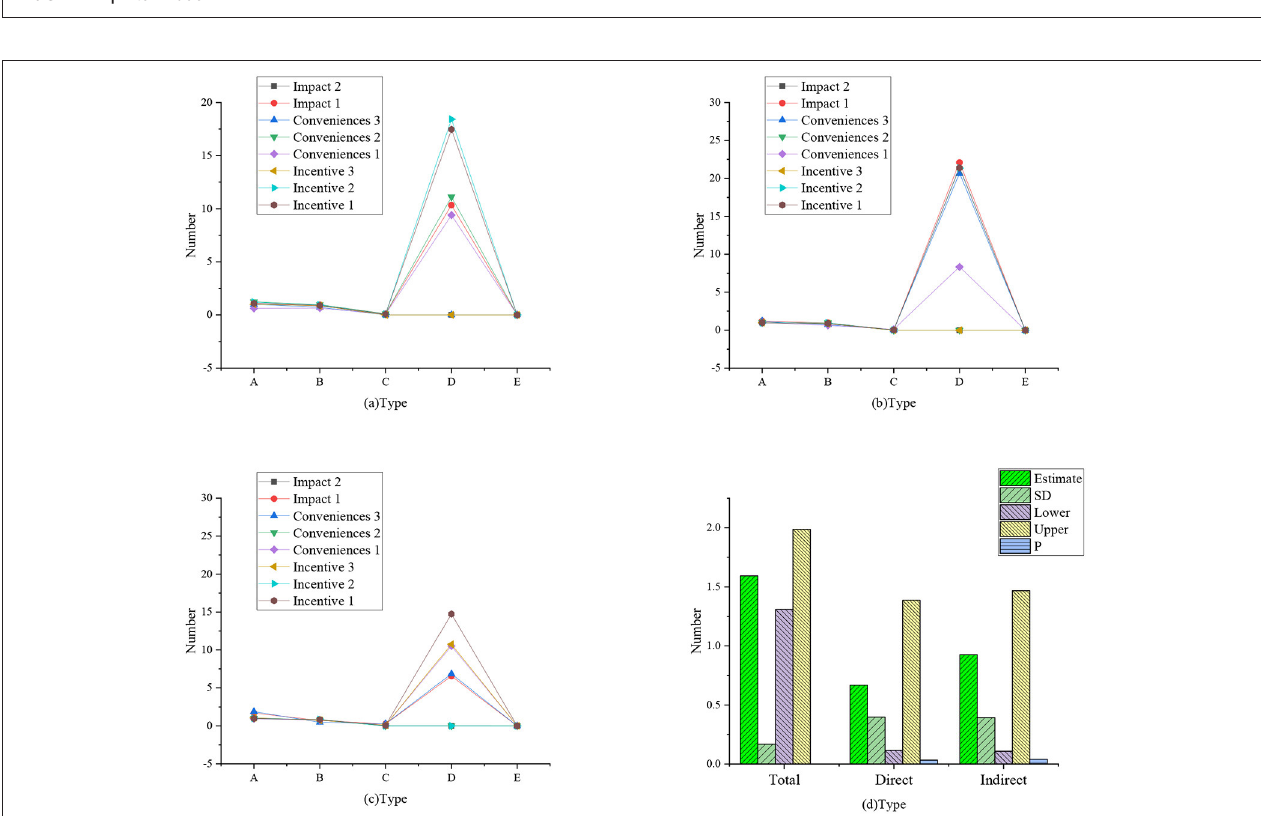
FIGURE 13 | Regression weights after the merger ( a : regression weight of influencing, incentive, and convenience factors; b : regression weights of learning, performance, and achievement factors; c : regression weight of trust, satisfaction, and reuse factors; d : arbitration analysis after the merger; A: non-standard; B: standardized C: SE value; D: T -value; E: P